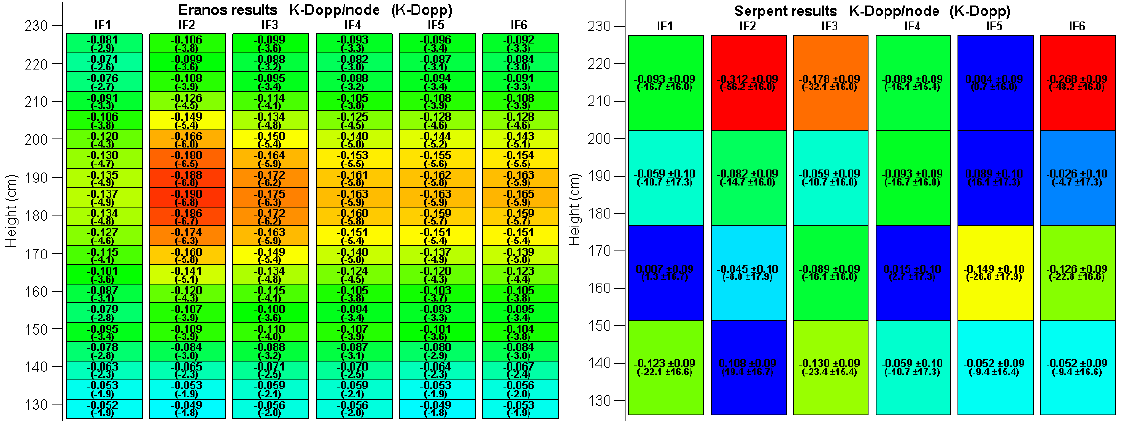
Figure 6. Doppler constant mapping for the six-batch core layout using the full core ERANOS model (left) and the radially infinite Serpent model